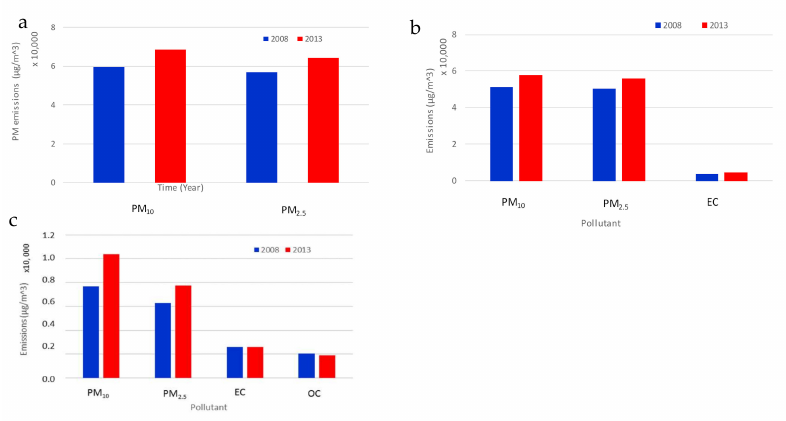
Figure 3. Di ff erentiation of the average ( a ) total, ( b ) residential heating and ( c ) tra ffi c PM 10 and PM 2.5 emissions between the March of 2008 and